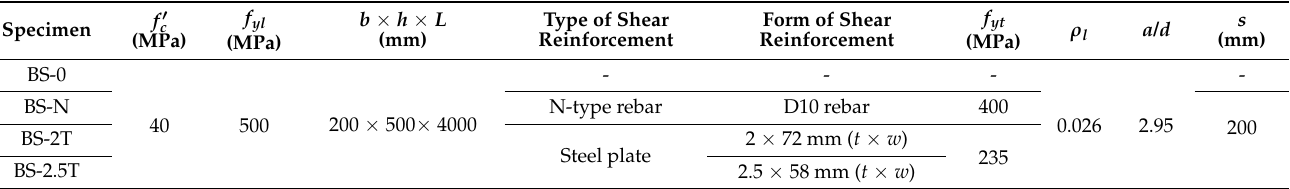
Table 1. Dimensions and material properties of the specimens.